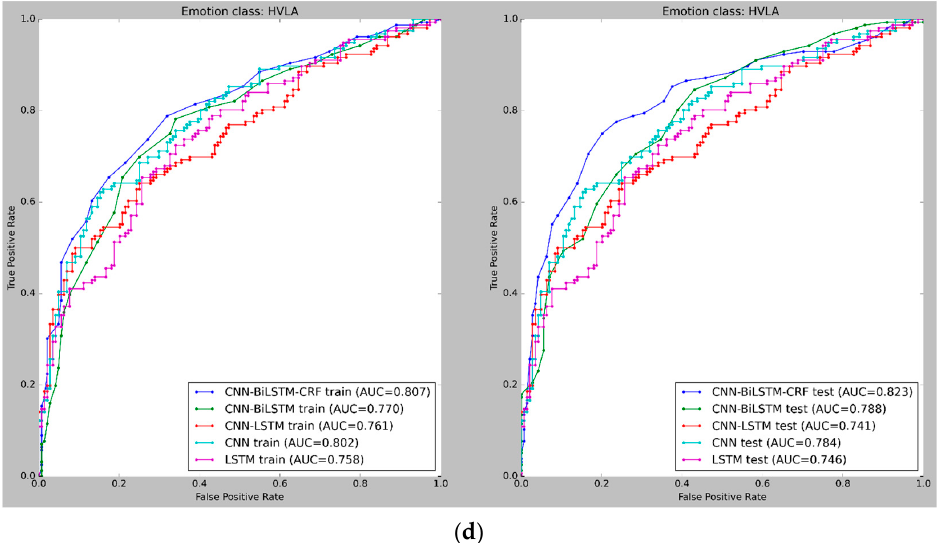
Figure 9. ( a ) ROC curves for emotion classification in Experiment 1, using cross-validated training and test datasets for High Valence High Arousal (HVHA). The curve shift towards the upper-left quadrant indicates improved model performance. ( b ) ROC curves for emotion classification in Experiment 1, using cross-validated training and test datasets for Low Valence Low Arousal (LVLA) class. ( c ) ROC curves for emotion classification in Experiment 1, using cross-validated training and test datasets for Low Valence High Arousal (LVHA) class. ( d ) ROC curves for emotion classification in Experiment 1, using cross-validated training and test datasets for High Valence Low Arousal (HVLA) class.